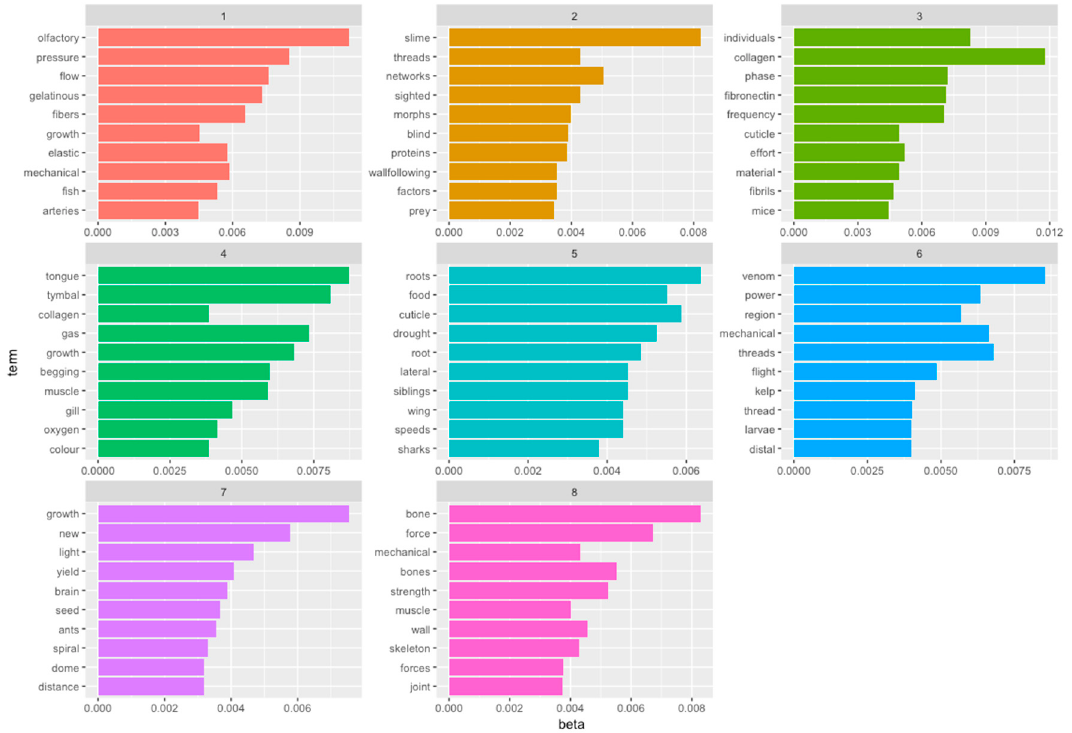
Figure 18. Latent Dirichlet Allocation plot that lists the highest frequency terms for an eight-topic analysis.